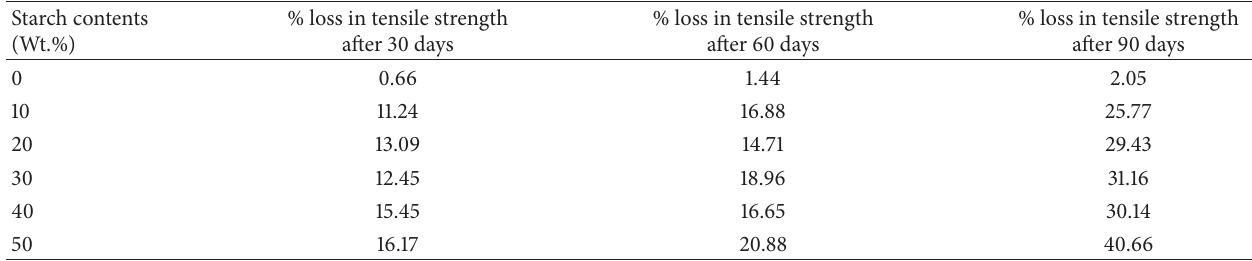
Table 1: Percent decrease in tensile strength of PP/PCS after biodegradation.